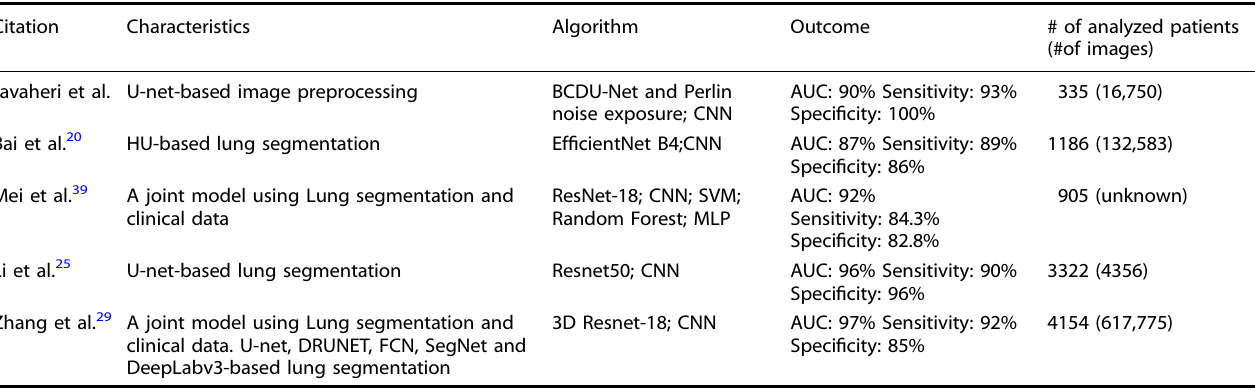
Table 4. Comparison of state-of-the-art Covid-19 classi fi cation approaches which used CT